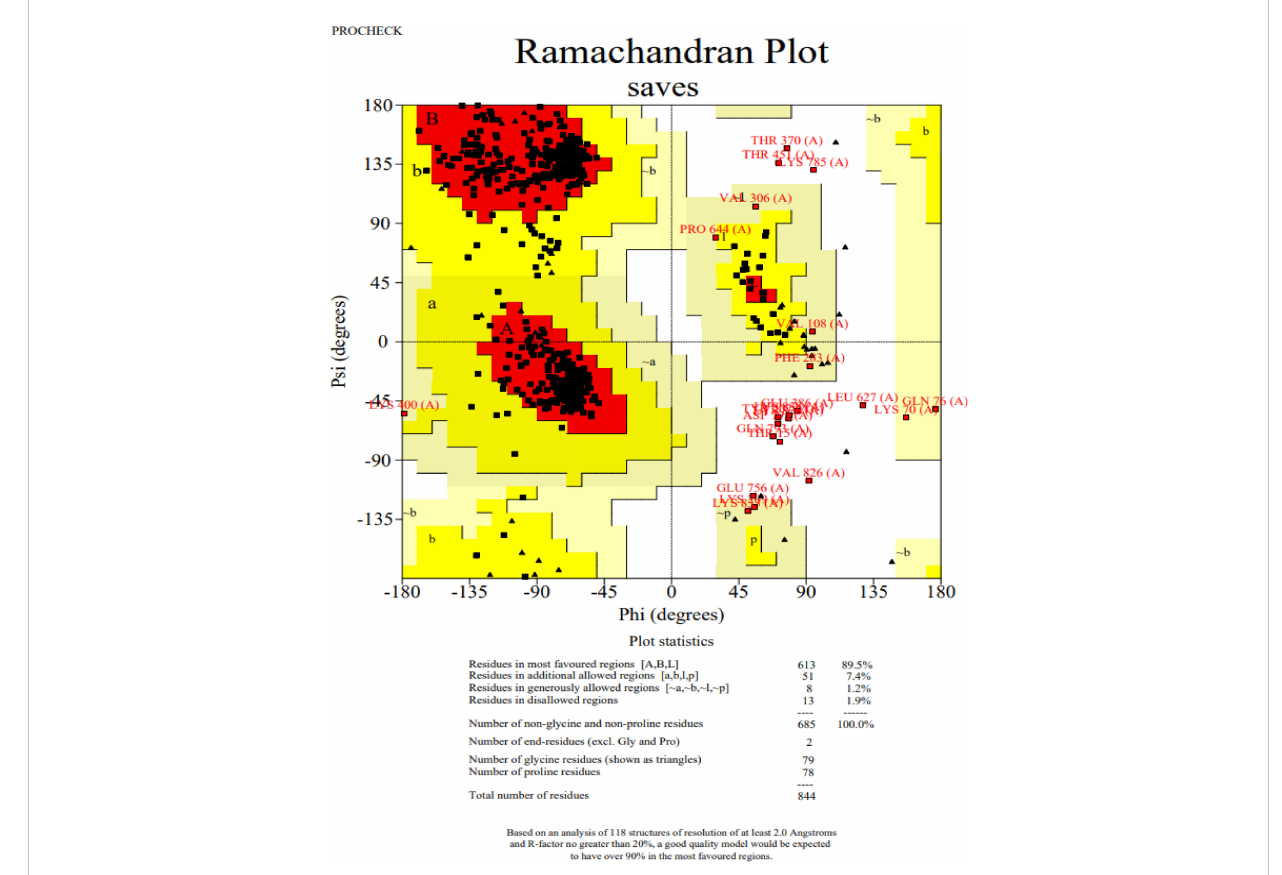
FIGURE 2 Post-modeling analyses of the 3D structure of VACCINE. Ramachandran plot depicting the stereochemical quality of VACCINE.